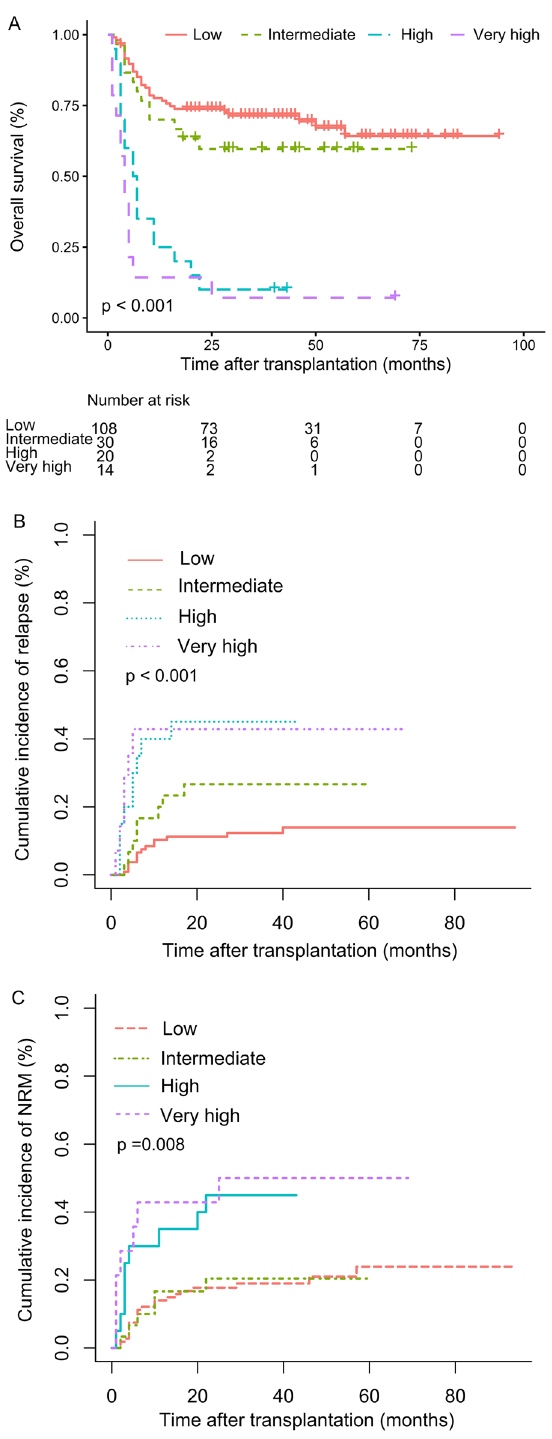
Figure 2. Comparison of overall survival ( A ), cumulative incidence of relapse ( B ) and cumulative incidence of NRM ( C ) by the AML-HCT-CR model in patients with low-, intermediate- and high-risk